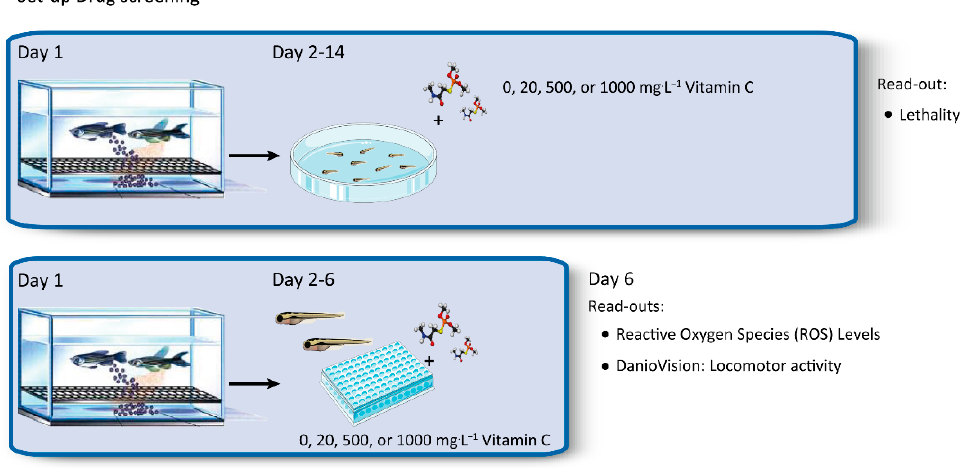
Figure 2. Schematic overview of zebrafish drug screening set-up.